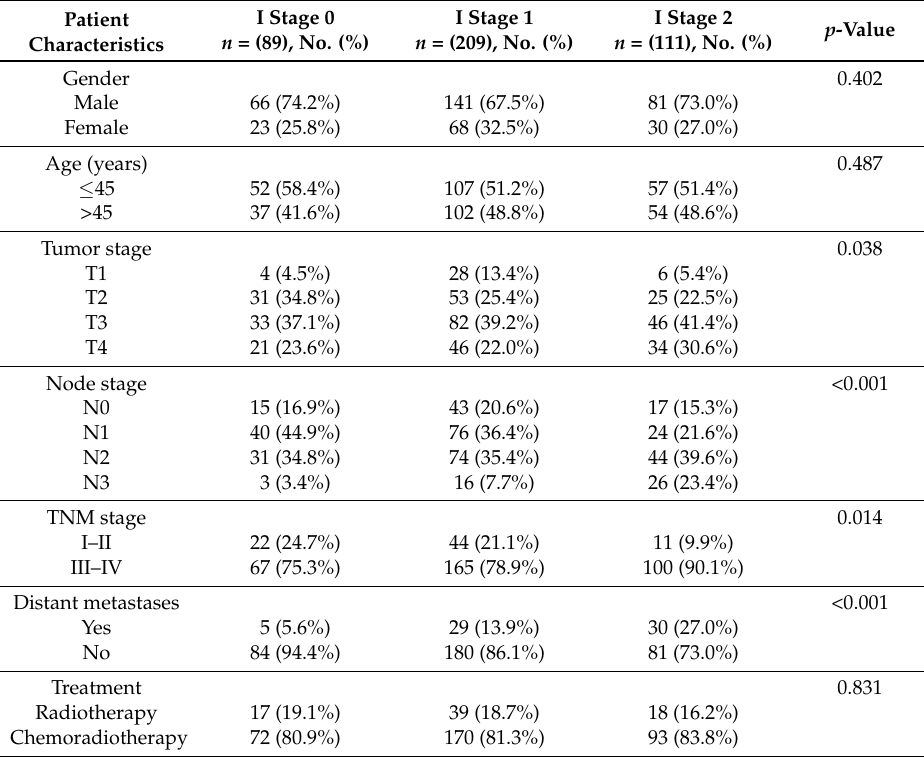
Table 3. Relationship between the I stage and clinicopathologic